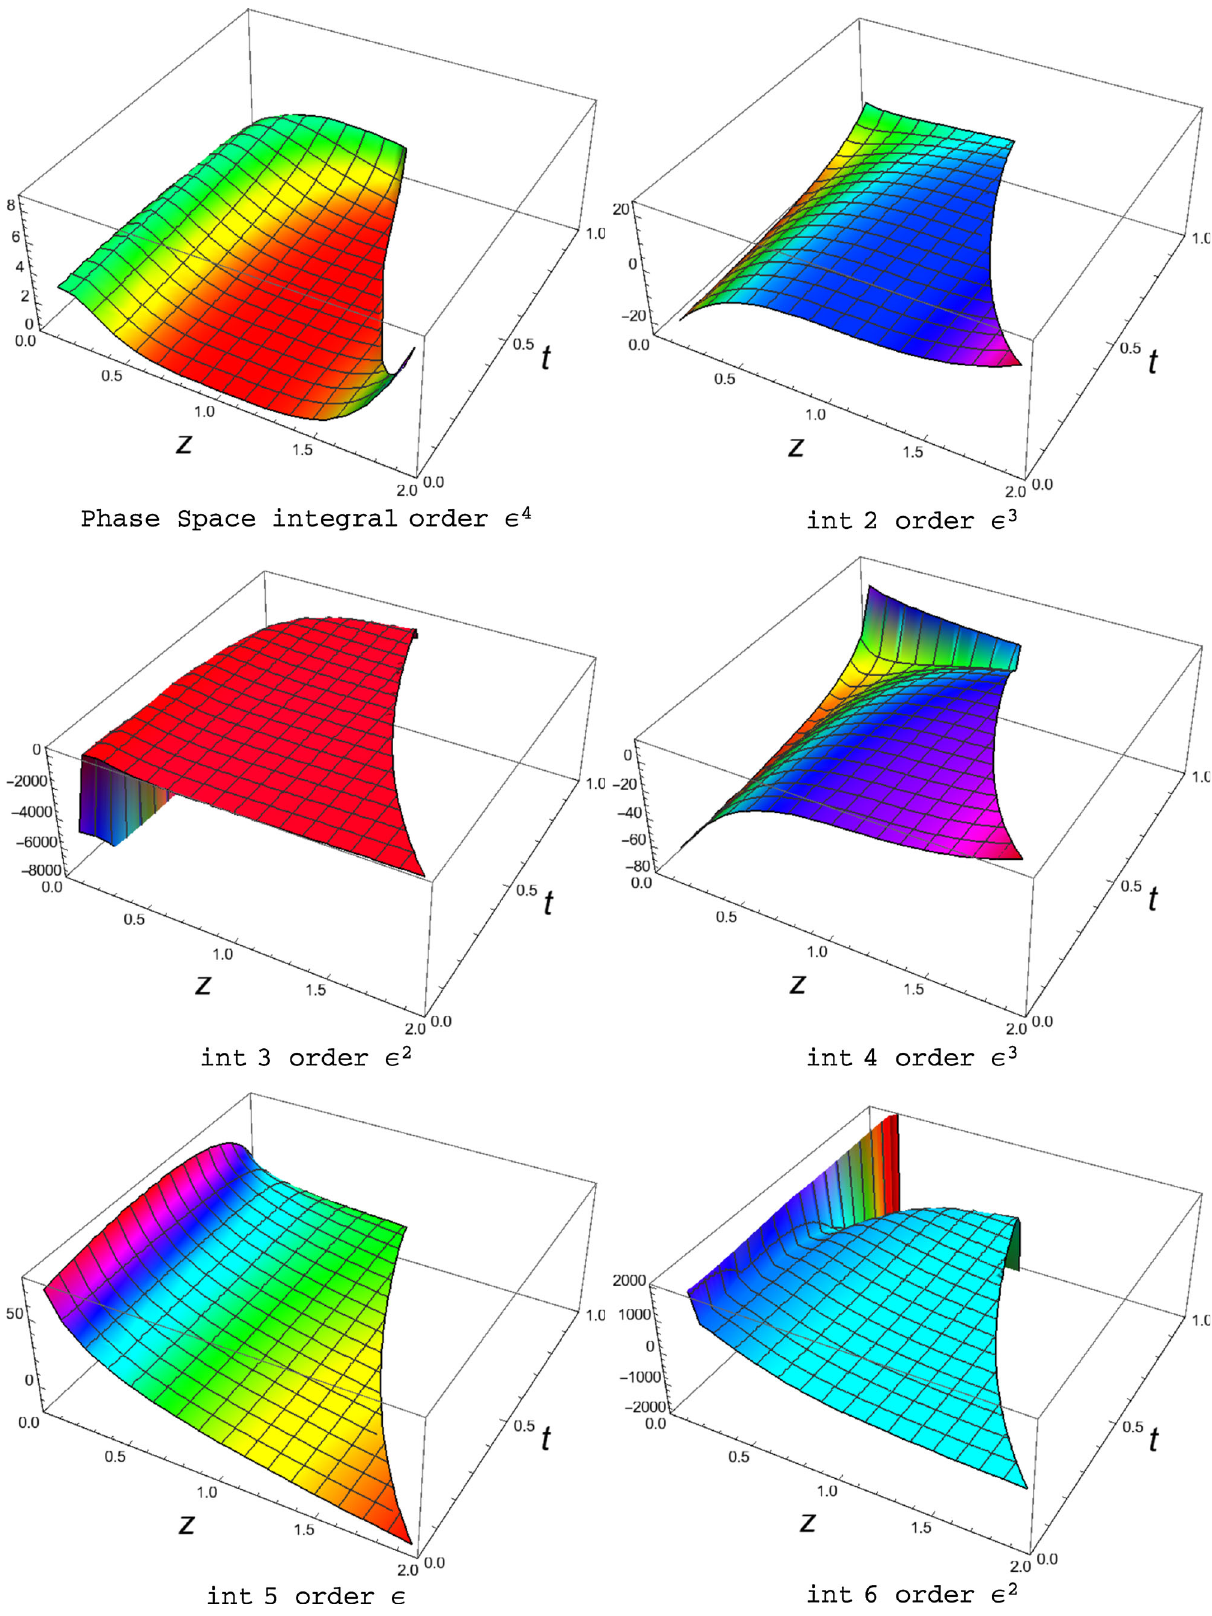
Fig. 5 Plots of the first order in (cid:3) which contains GPLs of weight four for the MIs ˆ I 1 ,..., ˆ I